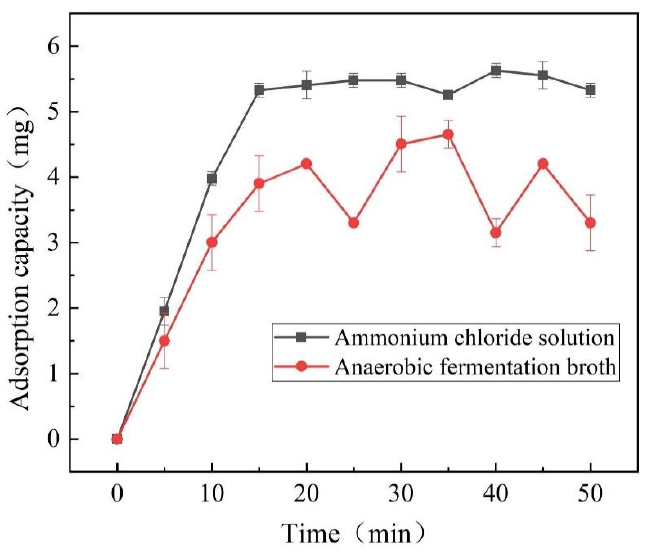
Figure 9. Comparison of resin adsorption capacities from the biogas slurry and ammonia chloride solution.